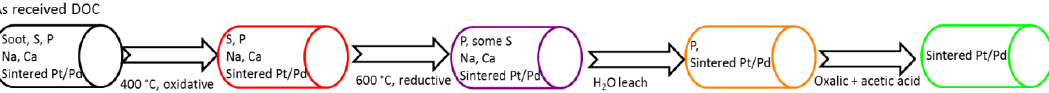
Figure 4. Visual comparison of samples before ( left ) and after ( right ) the oxidative soot removal step. Catalysts 2020 , 10 , x FOR PEER REVIEW